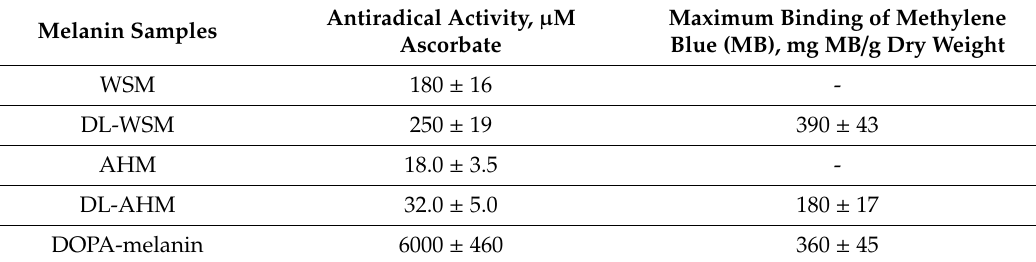
Table 2. Antiradical and sorption activity of the main samples of BSF melanins. Melanin